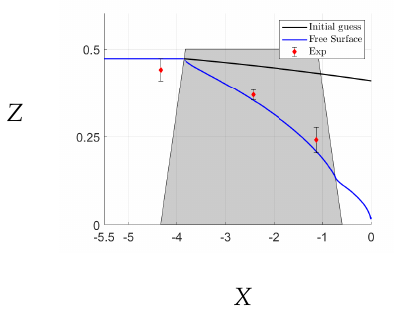
Figure 10. Free surface at flow rate 0.016 m 2 /s.